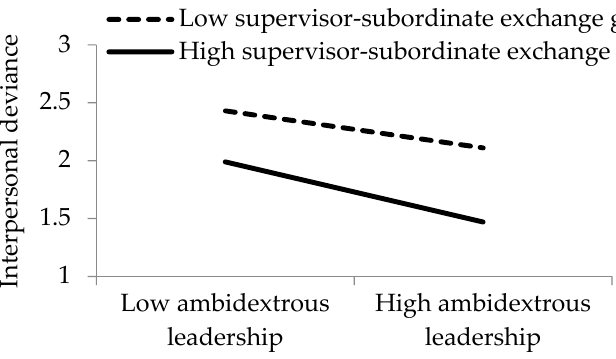
Figure 3. Influence of ambidextrous leadership on interpersonal deviance under different supervisor– subordinate exchange guanxi scenarios.